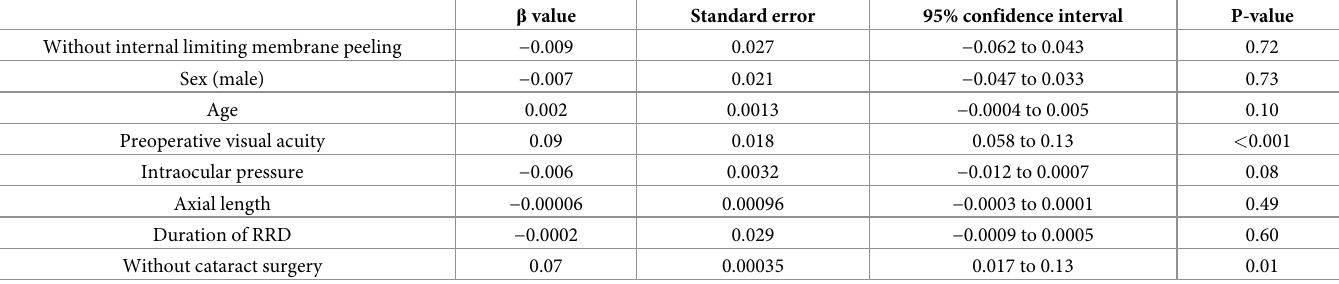
Duration of RRD 0.029 0.60 Without cataract